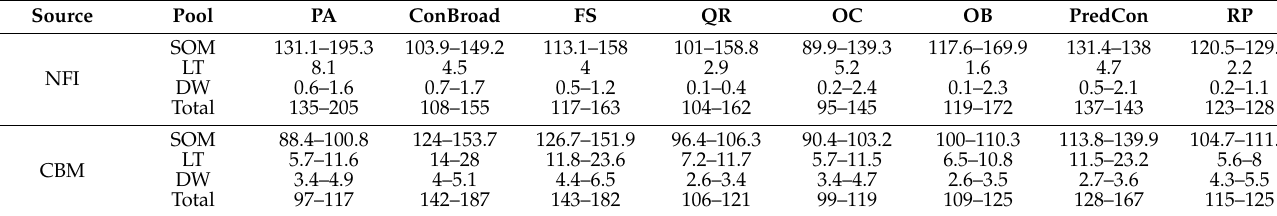
Table 3. Range of NFI measured (within 95% confidence interval of the mean) and initialized C stocks (tC ha − 1 ) in the subpools of CBM on forest types and CLUs. SOM = soil organic matter, LT = litter, DW = dead wood, Total = sum of the three subpools. Values without range represent an average of a small number of samples in the available data pool. Totals are rounded to the integer. See the abbreviations for forest types in Table 1.